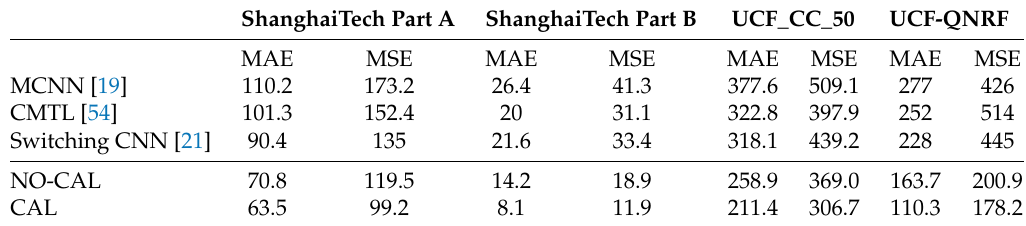
Table 6. The comparison between other structure and our approach.